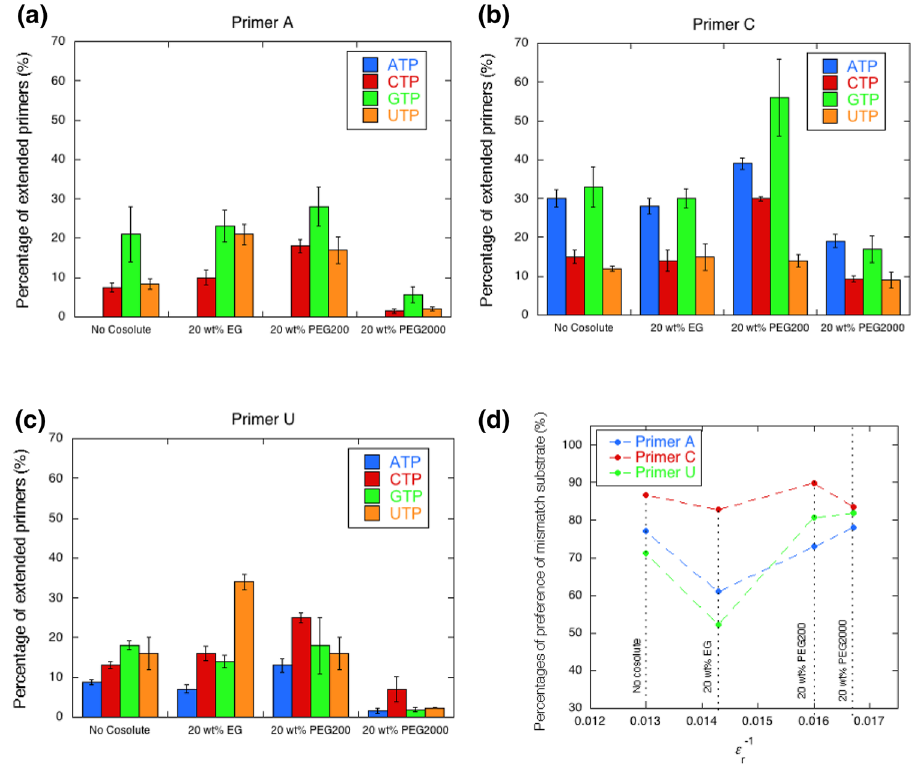
Figure 4. Percentages of extended primers with NTPs in each solution at the first position next to the 3 ′ terminal of ( a ) primer A, ( b ) primer C, and ( c ) primer U. ( d ) Percentage of the preference of mismatched substrate (sum of percentage of extended primer (%) with ATP, CTP, and GTP) over the mismatch primer extension (sum of percentage of extended primer (%) with all